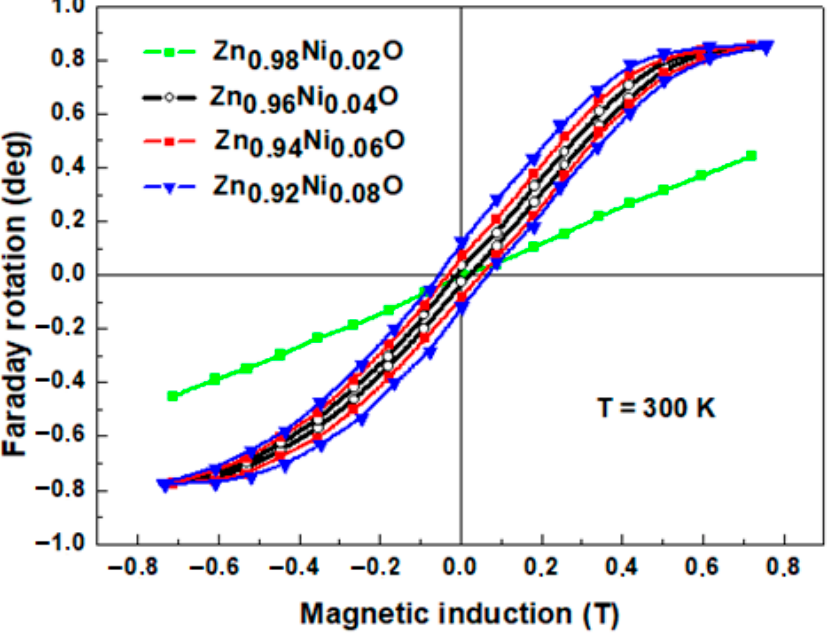
Figure 10. Magnetic field dependence of the Faraday rotation in Zn 1